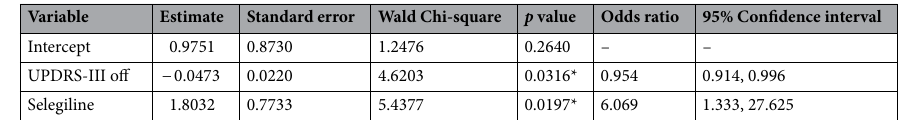
Table 4. Multivariate analysis of the factors between normal and abnormal platelet groups in PD patients. PD, Parkinson’s disease; UPDRS, Unified Parkinson’s Disease Rating Scale. *Statistically significant. ( p < 0.05).